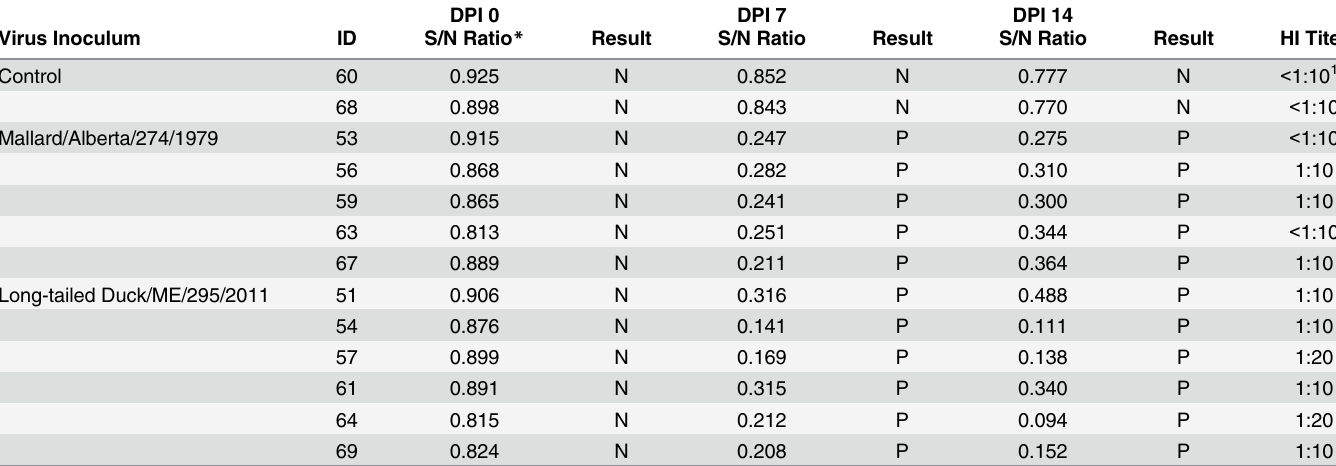
Table 10. Serological response of common eiders experimentally challenged with Influenza A H3N8 viruses.